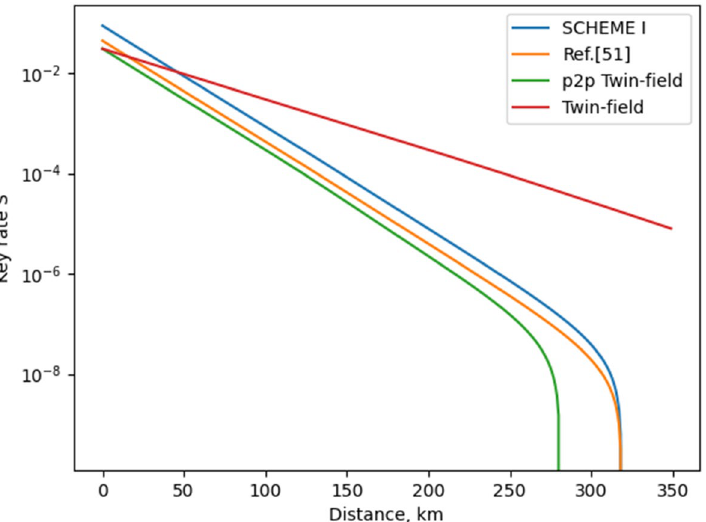
Figure 4. Key rates of different relativistic schemes. Details on the parameters used to evaluate the rates of the distinct schemes are given in the Supplementary Material. We should note that for the proposed scheme, as well as for the work of Ref. 51 , the following relation between µ α and µ β is used: 2 µ α = µ β . Also, µ in Eq. (5) is defined as µ = µ α + µ β , as proposed in Ref. 39 . The “p2p Twin field” is a twin field protocol conducted only between two parties; no relay node is used, as illustrated in Fig. 2b of Ref. 39 . The “Twin-field” presents the original model of Ref. 39 . Note that we omit the so-called slice sifting in the rate calculation of the twin-field QKD schemes presented in the